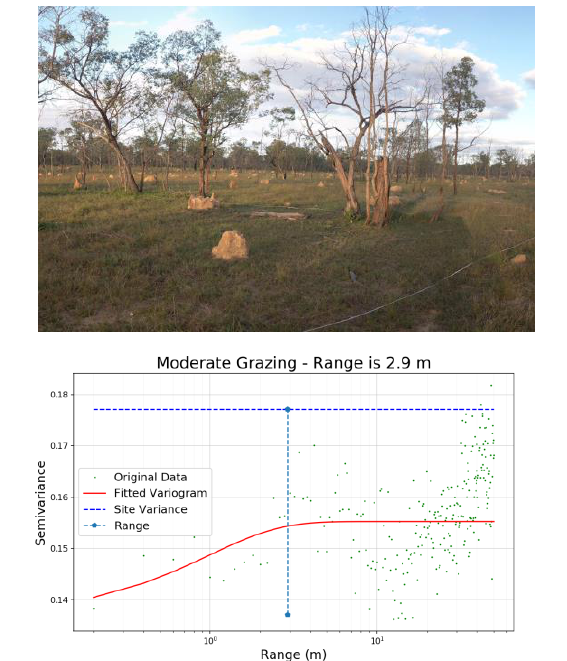
Figure 5. Typical moderate stocking rate. Wamble 8 is moderate stocking and range is 2.9 m